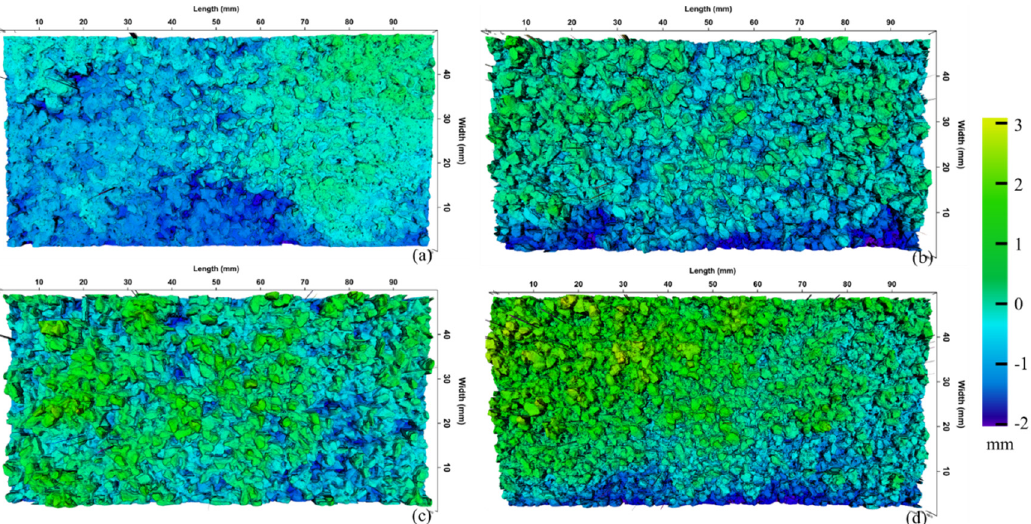
Figure 7. Colored 3D models of MS samples: ( a ) Type II, ( b ) MS-basalt, ( c ) MS-limestone, and ( d ) MS-steel slag. Table 5. Profile indicators of four kinds of